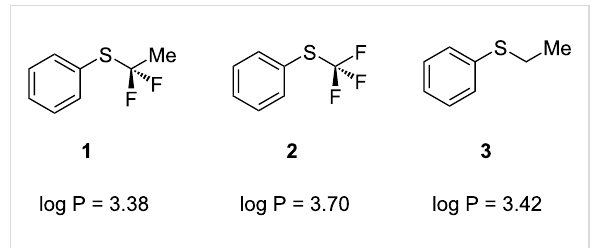
Figure 2: Comparison of log P values of comparative aryl thioether motifs [18].